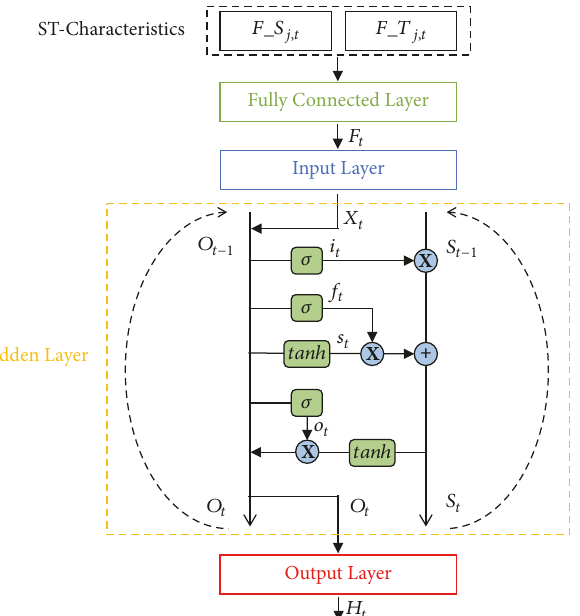
Figure 2: Structure of ST-LSTM